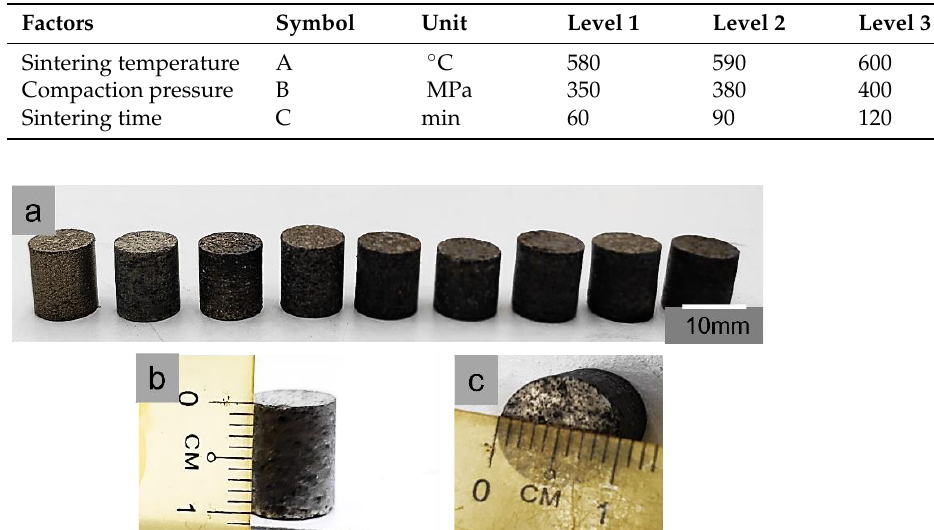
Table 3. Control factors (process parameters) and their levels.